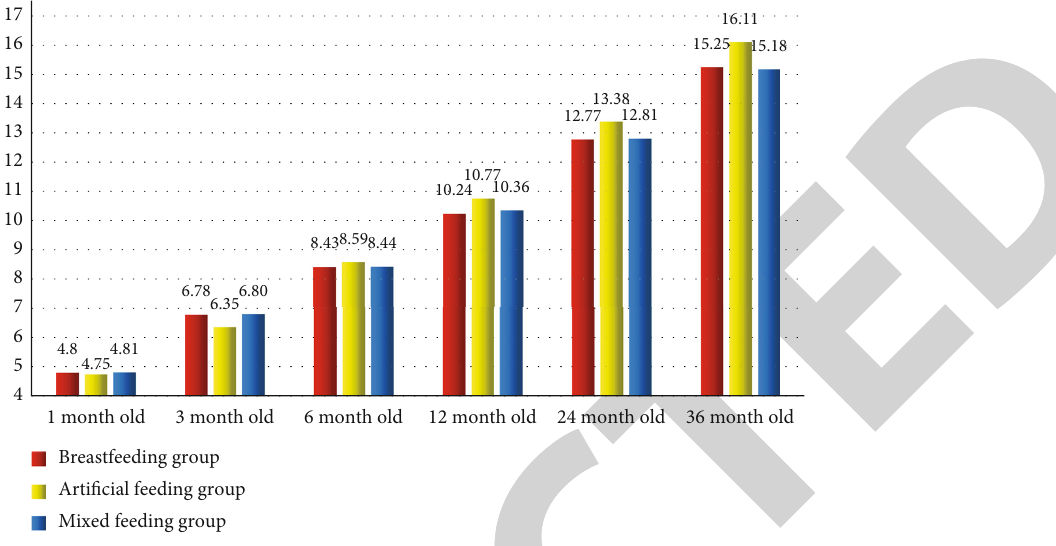
Figure 2: E ff ects of feeding methods in di ff erent periods on weight development. Table 3: The Kaup index under di ff erent feeding